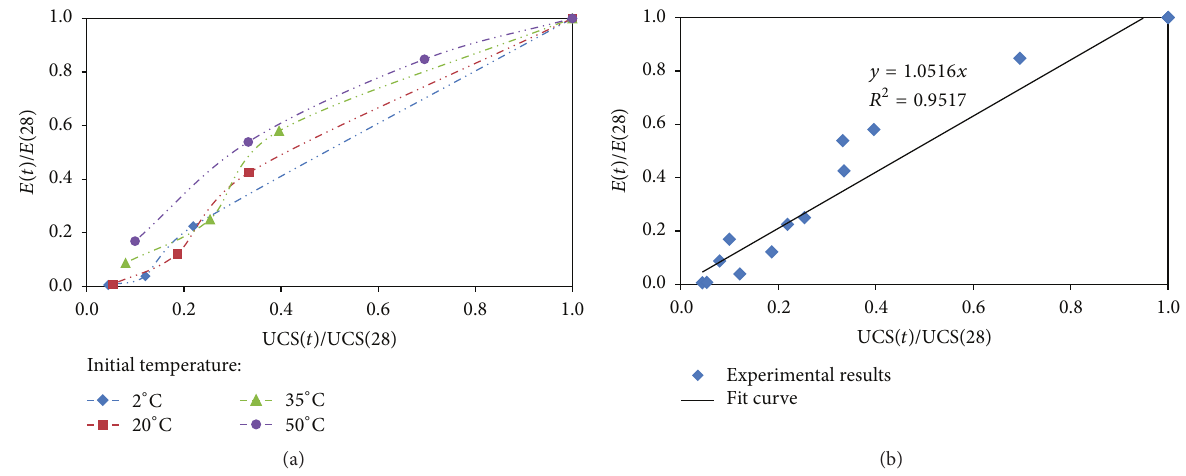
Figure 8: Relationship between 𝐸(𝑡)/𝐸(28) and UCS (𝑡)/ UCS (28) : (a) evolution of 𝐸(𝑡)/𝐸(28) with UCS (𝑡)/ UCS (28) at different initial temperatures and (b) the fit curve for 𝐸(𝑡)/𝐸(28) and UCS (𝑡)/ UCS (28)